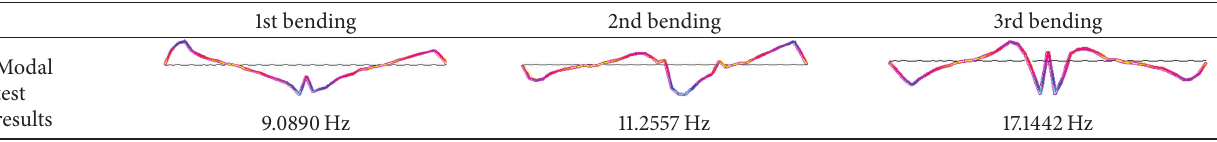
(b) Modal test response (spectra) Figure 5: Modal test results. Table 4: Results of the modal test of the cable-stayed bridge model.